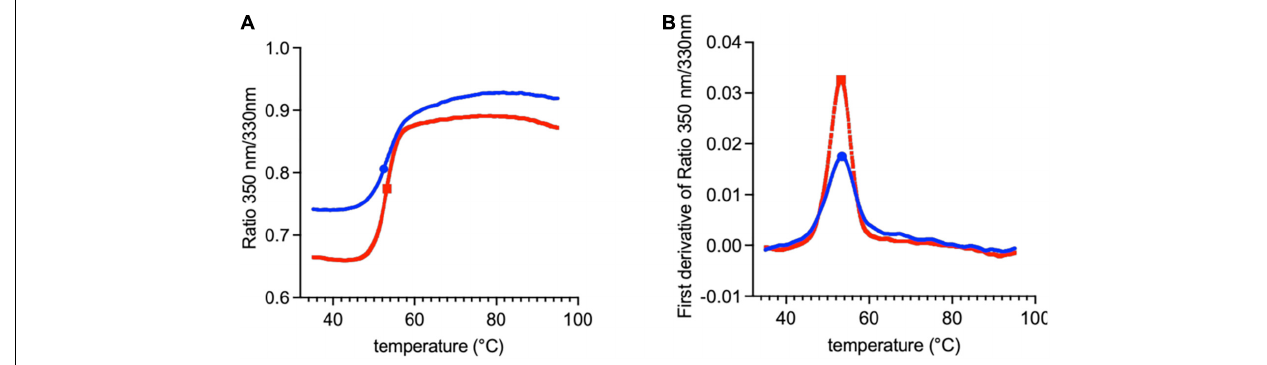
FIGURE 3 | DSF traces of SARS-CoV-2 RBD produced in HEK293F cells (blue) and in L. tarentolae (red). The raw traces (A) and the first derivative (B) of the variation of the ratio of the protein intrinsic fluorescence at 350 and 330 nm during a DSF experiment are shown.